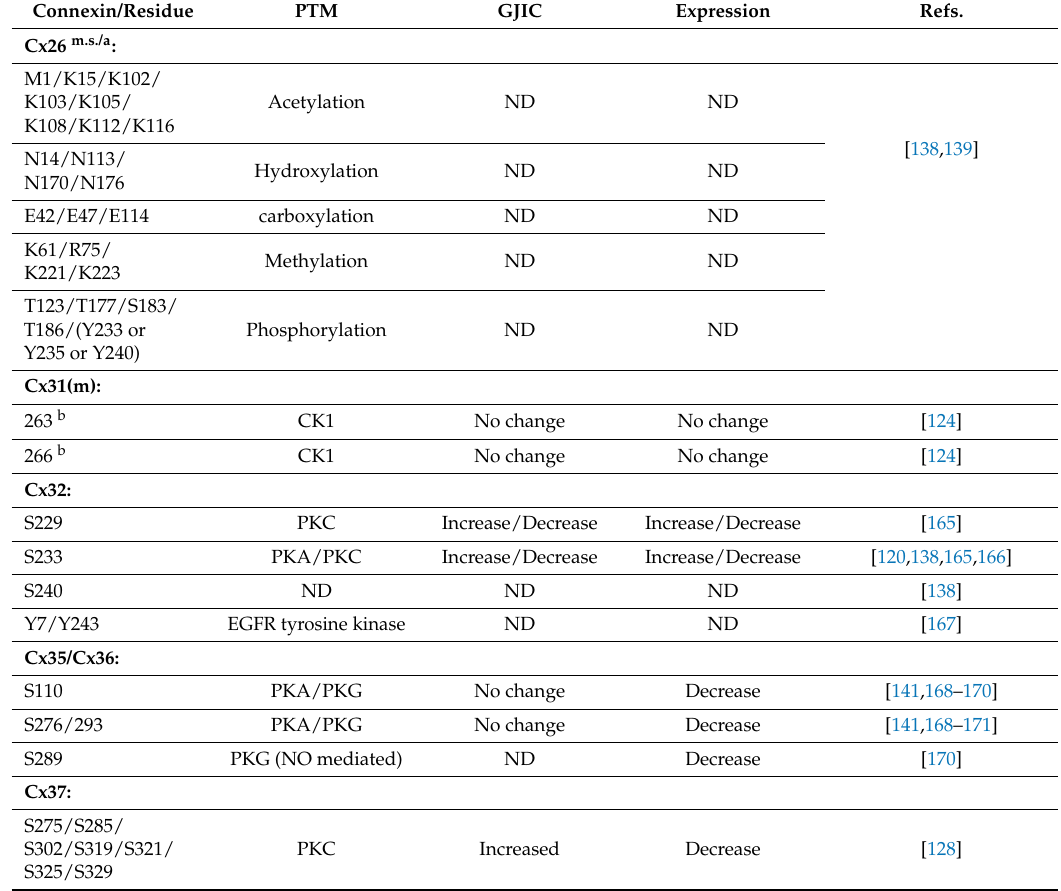
Table 1. Connexin post-translational modifications (PTMs) and functional